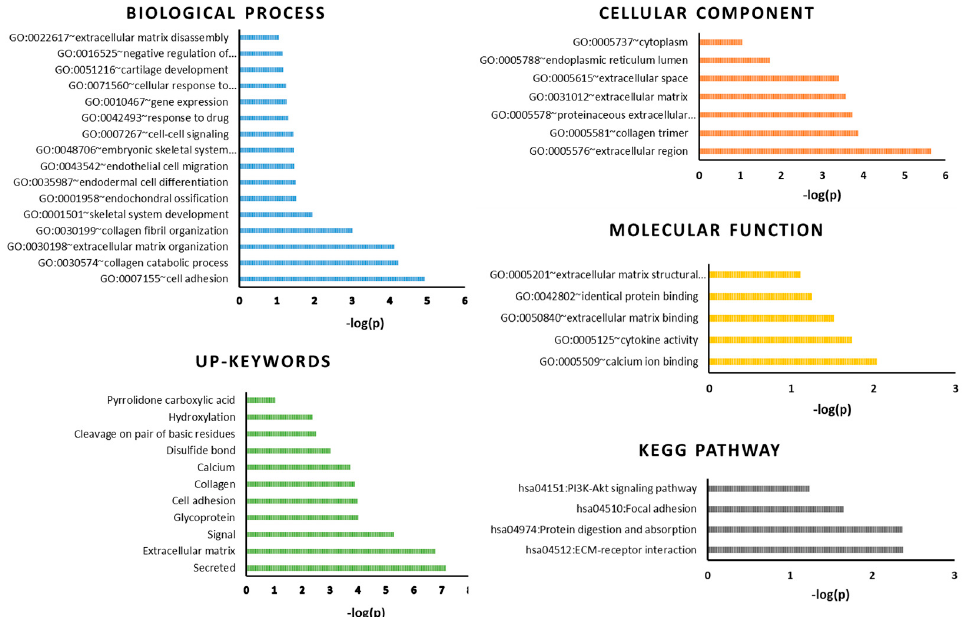
Figure 2. DAVID gene ontology enrichment analysis for common DEGs performed for biological process, cellular component, molecular function, significant keywords, and KEEG pathway.